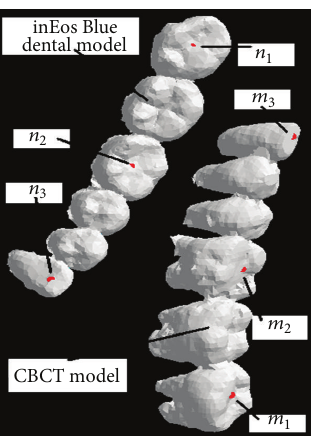
Figure 7: The initial position of model and corresponding points.